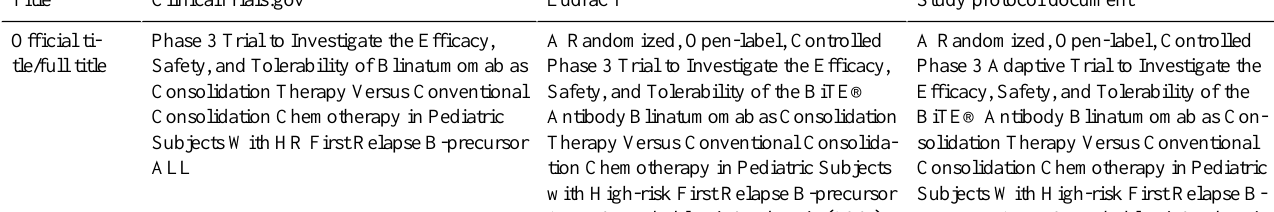
Study protocol documentEudraCTClinicalTrials.govTitle A Randomized, Open-label, Controlled Phase 3 Adaptive Trial to Investigate the Efficacy, Safety, and Tolerability of